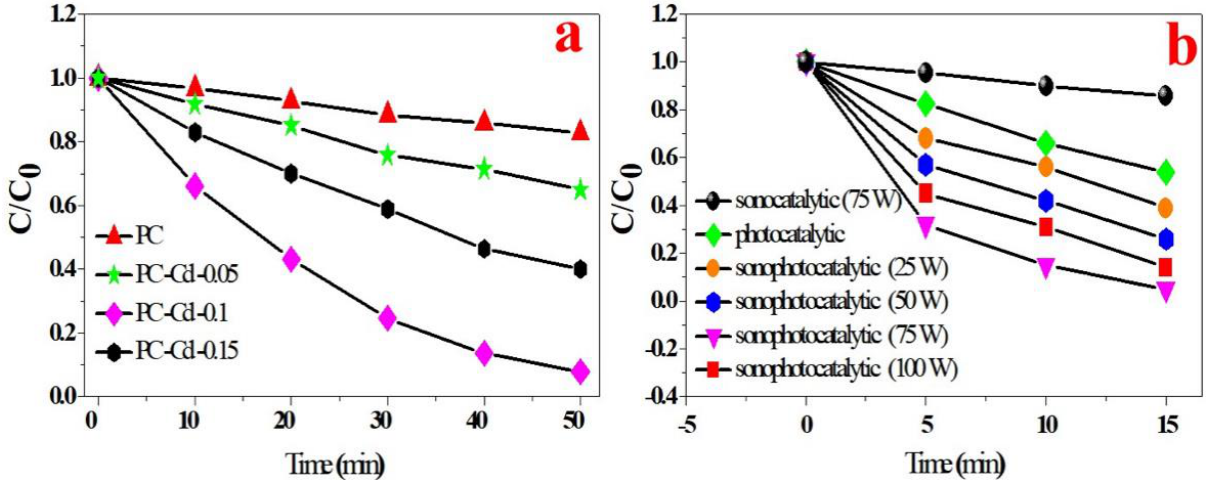
Figure 6. ( a ) Photocatalytic degradation curves of PAN/g-C 3 N 4 /CdS heterojunctions. ( b ) Sono-photocatalytic degradation curves of PAN/g-C 3 N 4 /CdS heterojunctions (PC-Cd-0.1).